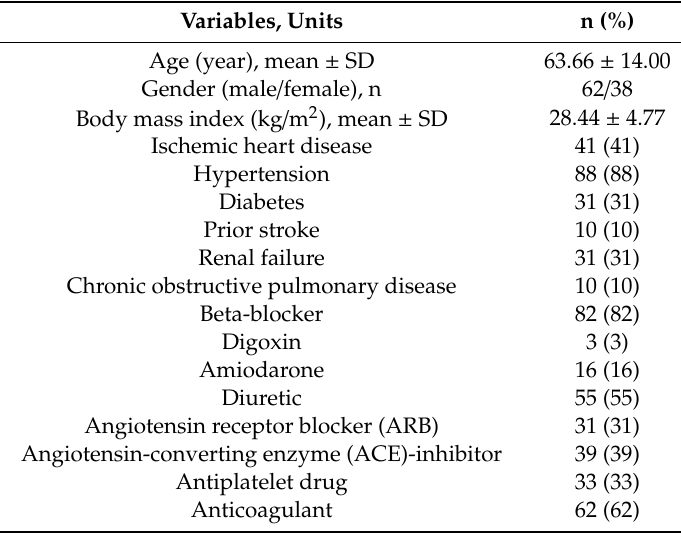
Table 1. Patients baseline characteristics.